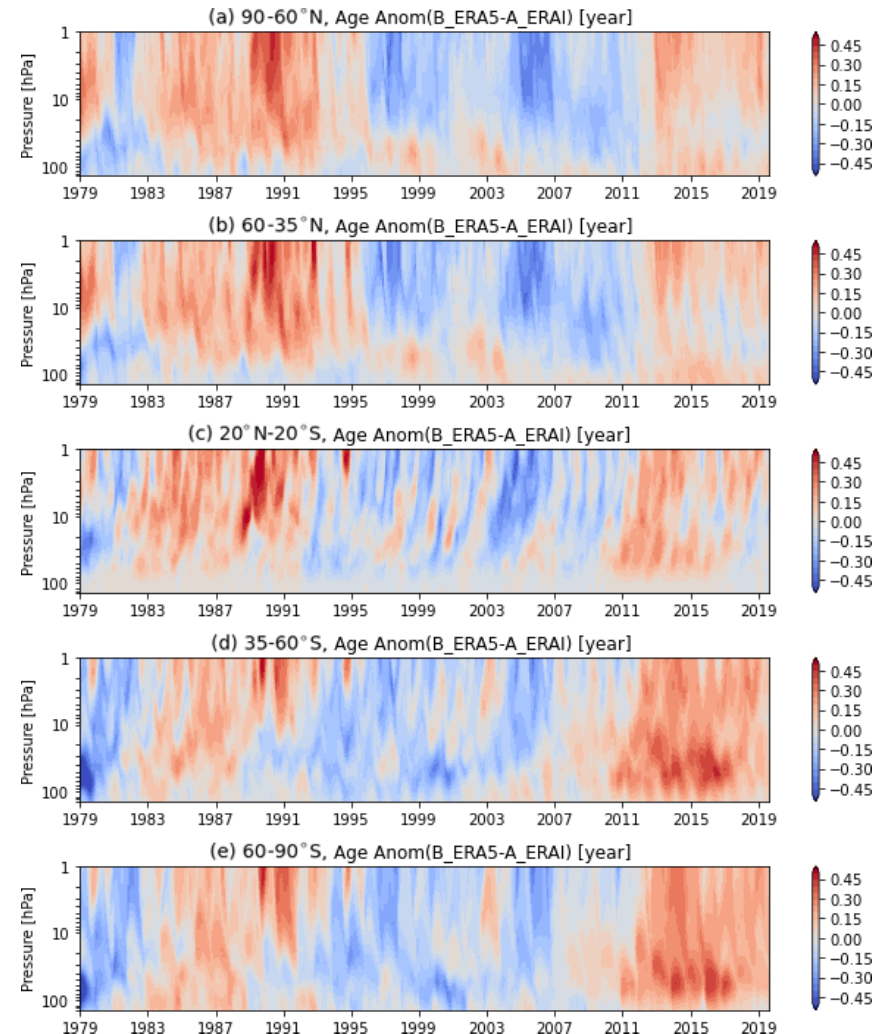
Figure 12. Pressure–time series of differences in mean age of air (AoA) between A_ERAI and B_ERA5 (B_ERA5–A_ERAI) over 1979– 2019 (August) for (a) 90–60 ◦ N, (b) 60–35 ◦ N, (c) 20 ◦ N–20 ◦ S, and (d) 35–60 ◦ S and (e) 60–90 ◦ S zonal regions. Data have been deseason- alised by applying a 12-month running